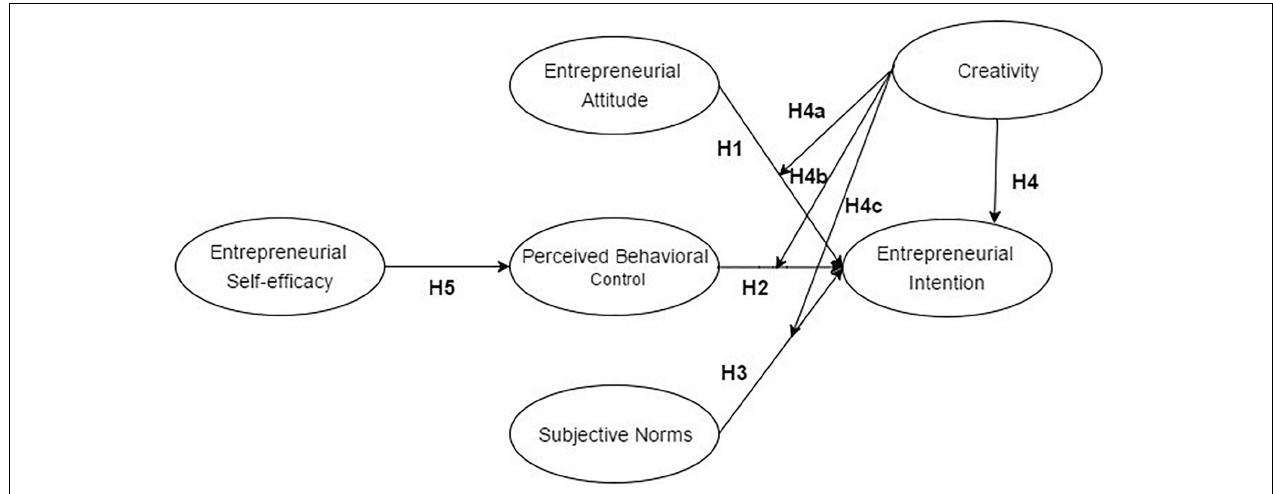
FIGURE 1 | The proposed structural relationships between creativity and entrepreneurial intention based on the theory of planned behavior model.